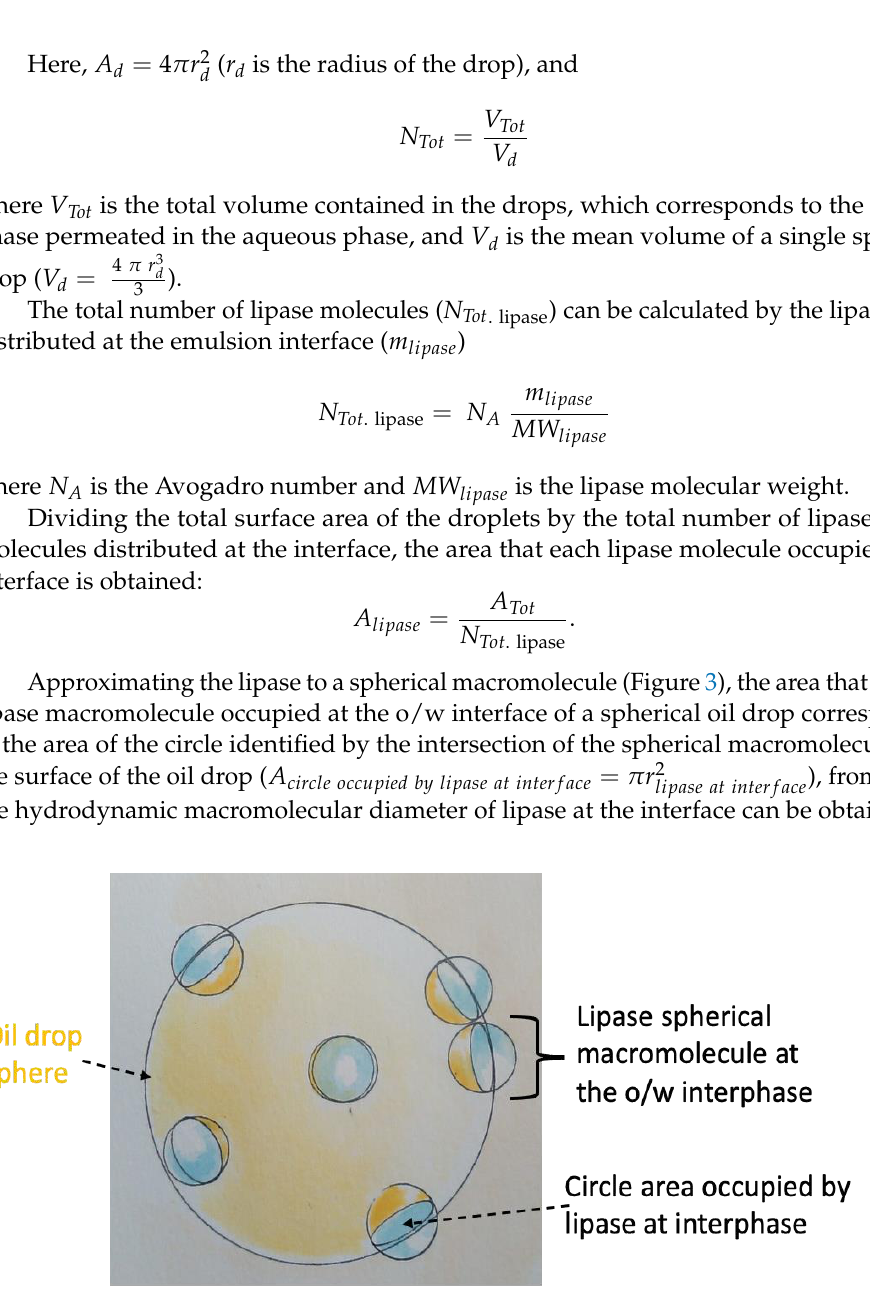
Figure 3. Schematic representation of lipase approximated to spherical macromolecules distributed at the oil (yellow)/water (light blue) interface of a spherical oil drop. The circle area occupied by a single lipase macromolecule is also highlighted. (To simplify the scheme, only some macromolecules from various perspectives were